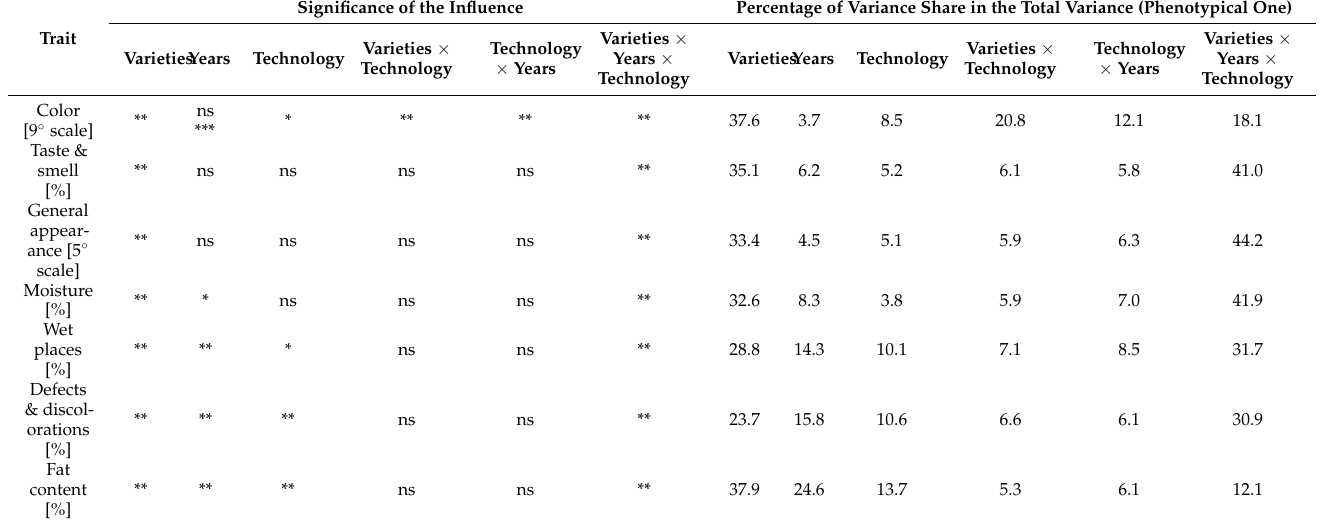
Table 4. The influence of varieties, technology, years and their interaction on the color, consistency, appearance, taste and smell, moisture, wet places, defects and discolorations, and fat content of PC and the percentages of participation of varieties, technology, years, and interaction cultivar x technology years in total variance. Significance of the Influence Percentage of Variance Share in the Total Variance (Phenotypical One) Trait × VarietiesYears Technology Varieties